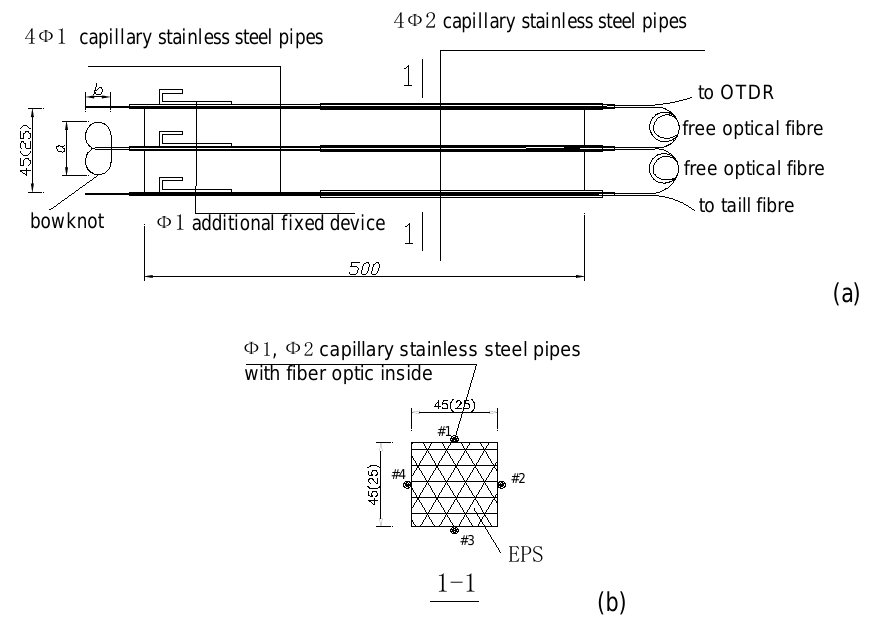
Fig. 4 Draft of the fourth generation transducer. (a) Elevation view of the Sensor. (b) Cross Figure 4. Draft of the fourth-generation transducer. (a) Elevation view of the Sensor. (b) Cross section of the sensor (unit: Section of the Sensor. (unit: mm)